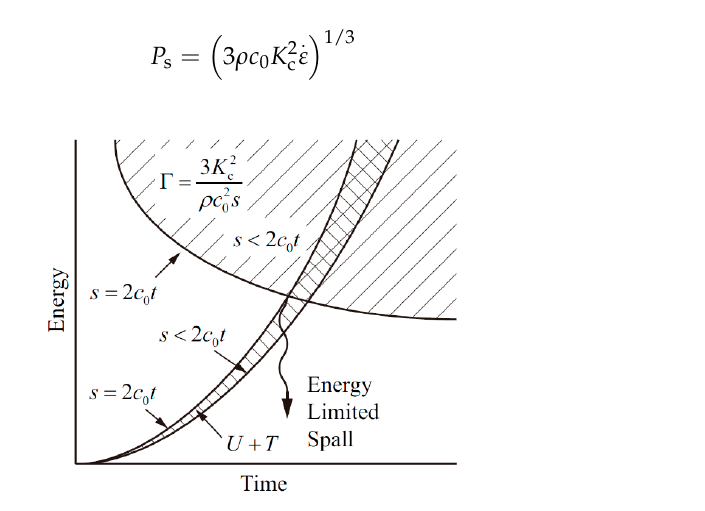
Figure 8. Schematic diagram of Grady brittle spallation model.